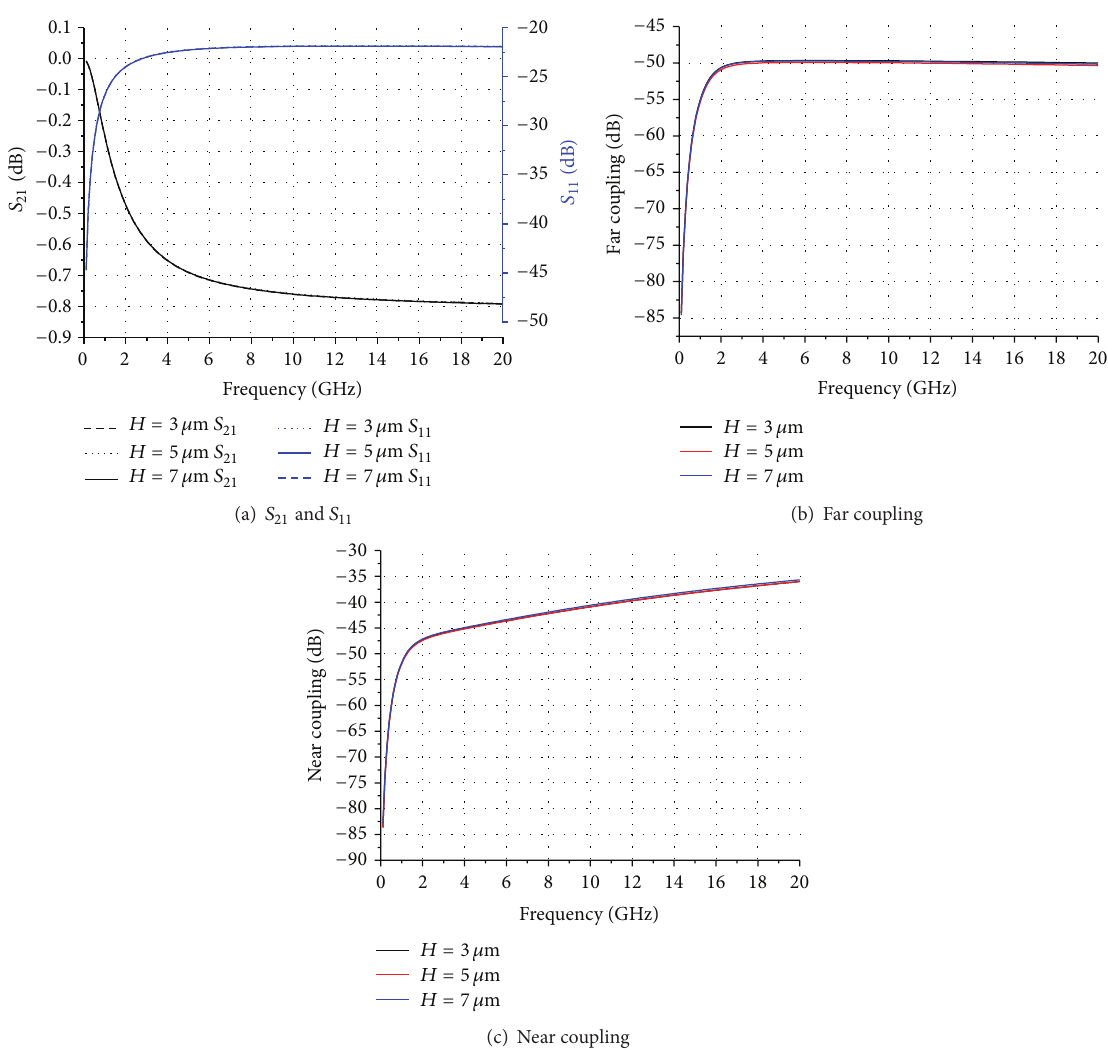
Figure 10: 𝑆 parameters of the TSV model with different bump height.